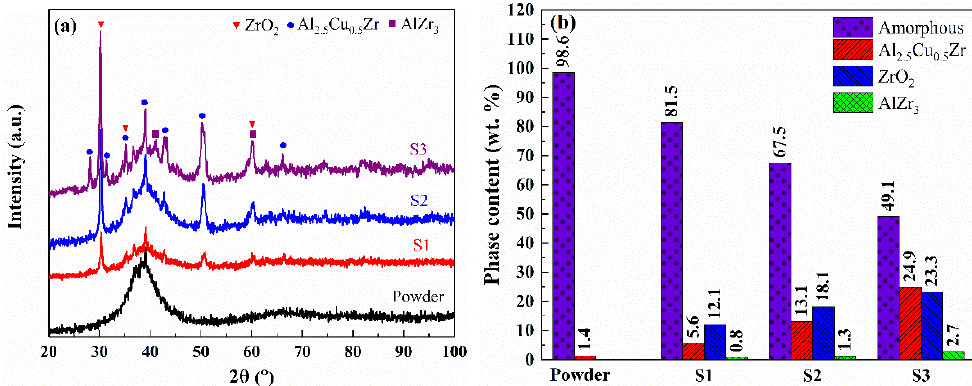
Figure 5. ( a ) XRD results and ( b ) the weight percent of the phases for the (Cu 43 Zr 47 Al 7 Ag 3 ) 99.5 Co 0.5 amorphous powder and coatings.